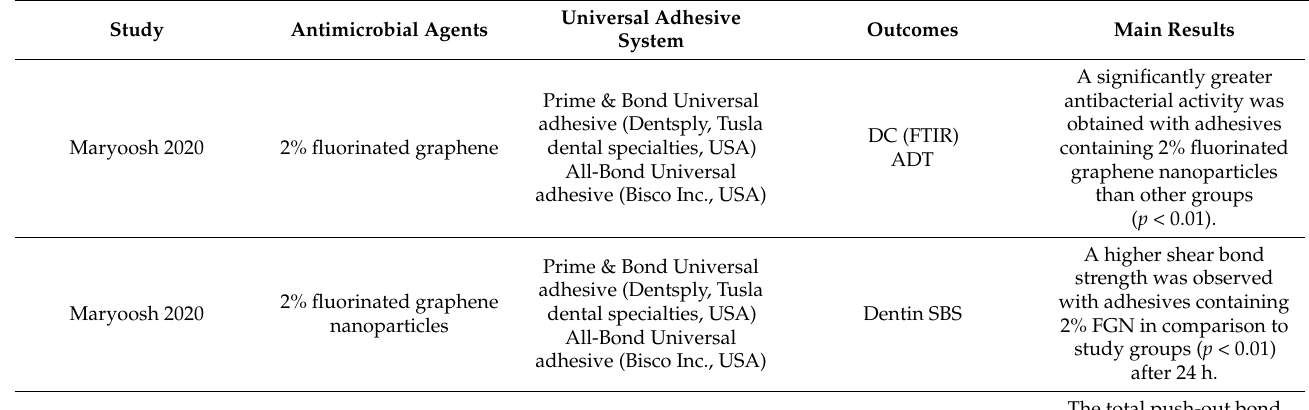
Table 2. Demographic and study design data of the included